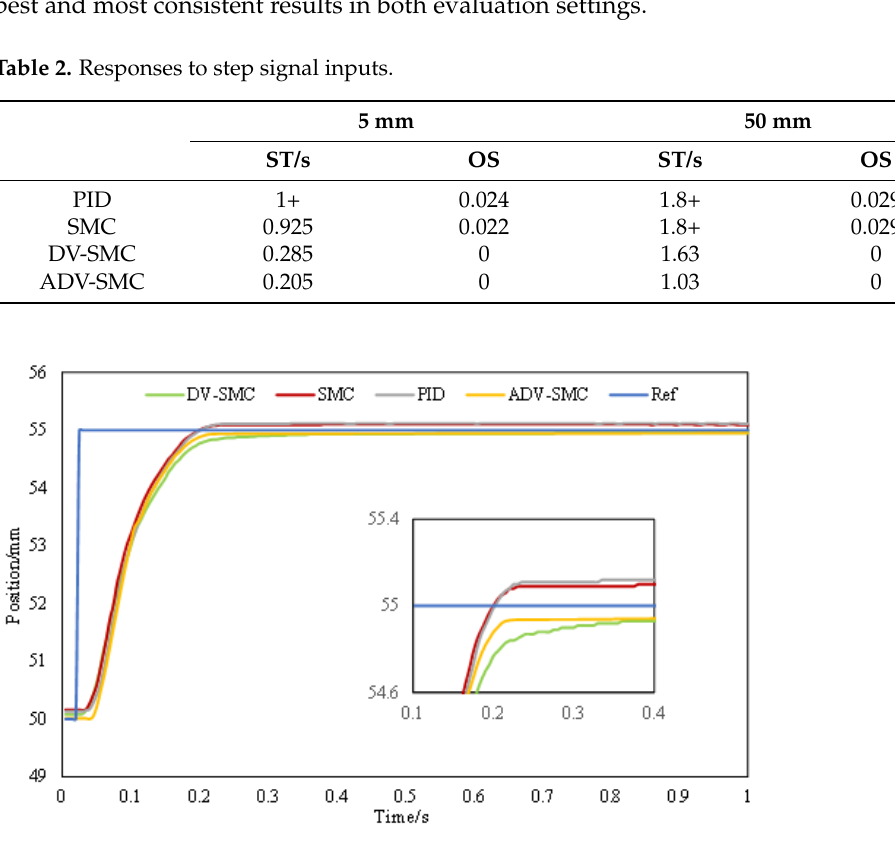
Figure 5. Experimental response to 5 mm step input.